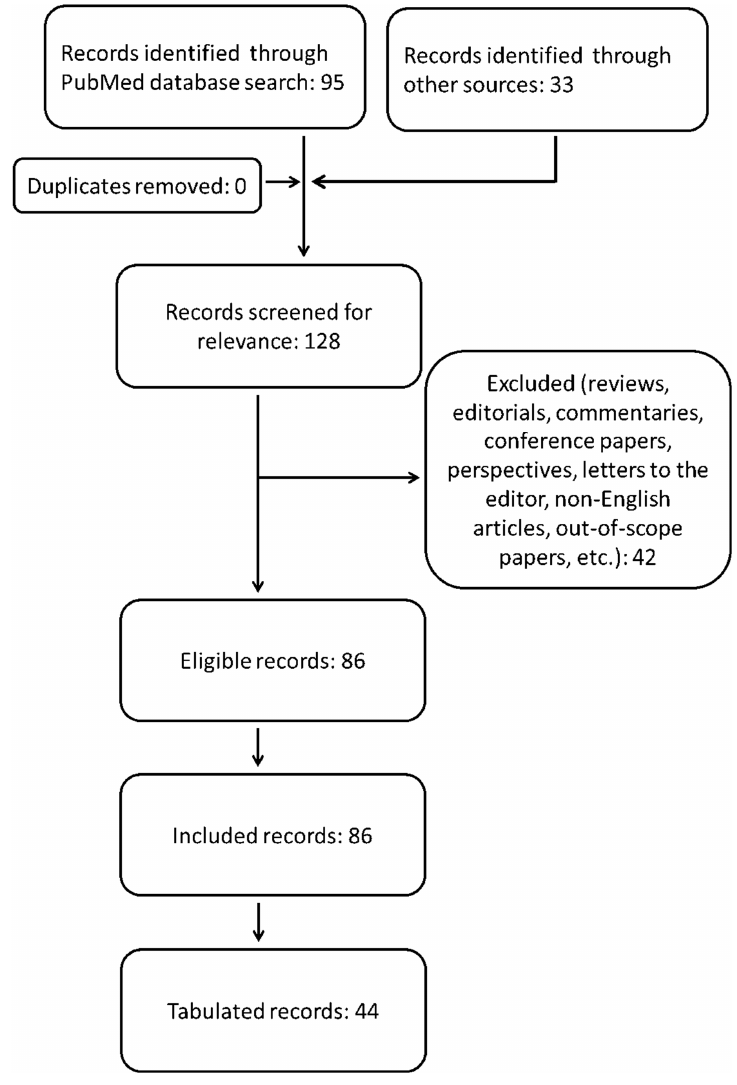
Figure 1. Flowchart of the literature